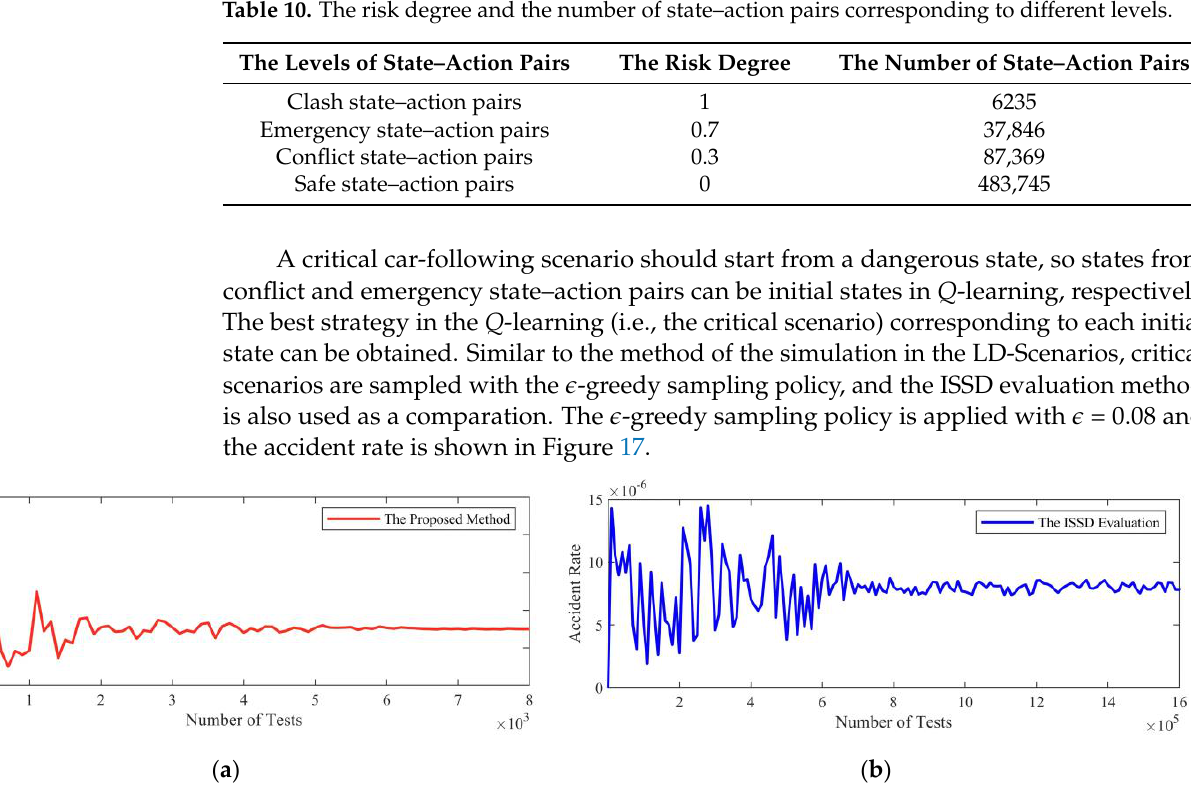
Figure 17. The accident rate of simulation tests of the HD-Scenario. ( a ) The red line denotes the accident rate by the proposed method. ( b ) The blue line denotes the accident rate by the ISSD evaluation method.